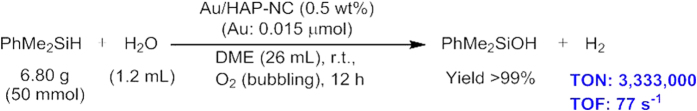
Scale-up reaction using Au/HAP-NC (0.5 wt%).